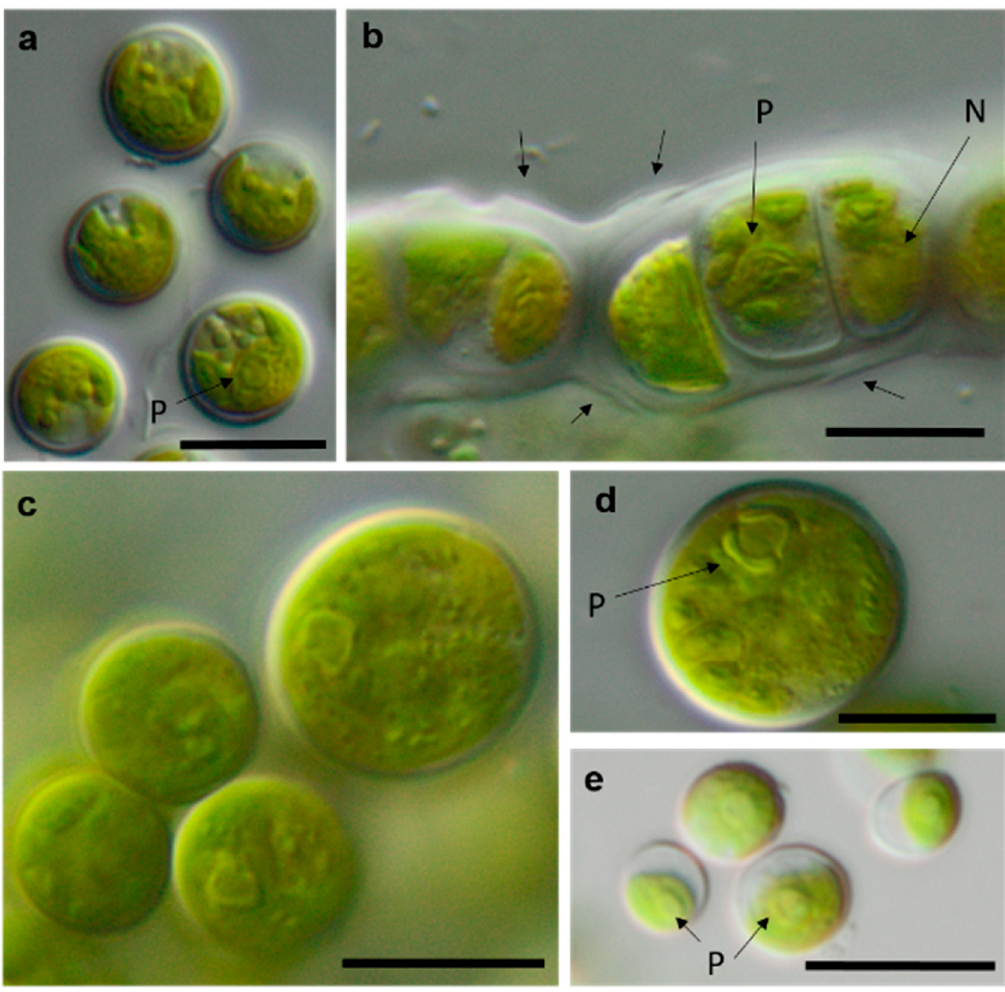
Figure 14. Photomicrographs of Ulvophyceae isolates. ( a ) Desmochloris cf. halophila TT-4-1-I, ( b ) cf. Chlorothrix NN-1-1-M a corrugated cell wall, ( c , d ) Halochlorococcum sp. TT-4-1-O ( d ) single cell with lateral pyrenoid surrounded by two starch grains, and ( e ): Planophila sp. G2C with an unlobed chloroplast and one pyrenoid. Arrow labels: N = nucleus and P = pyrenoid. Scale bars: 10 µm.